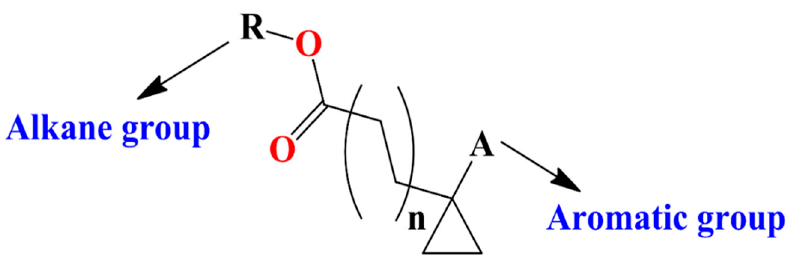
Figure 3. Fragment has detrimental effect on PCE value.